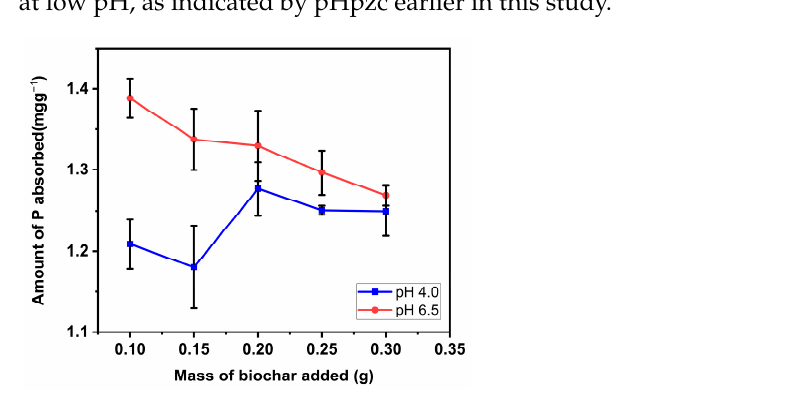
Figure 8. P retention and availability of soil/Douglas fir biochar treated with MgCl 2 · 6H 2 O + KOH solutions (MKB) mixture. (Values shown are mean of n = 3, error bars shown as standard deviation).